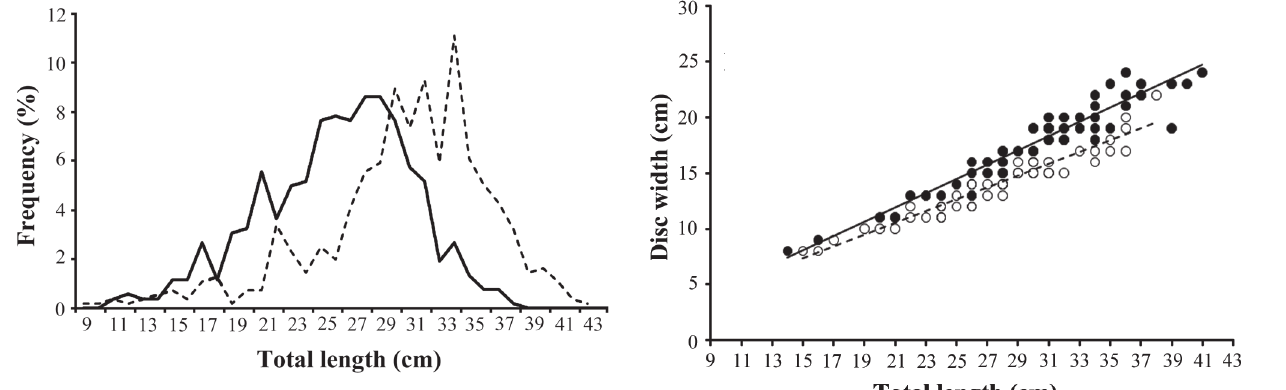
Fig. 4. Size frequency distribution of Discopyge tschudii sampled during 2004-2007. Males (dotted line) n= 564 and females (continuous line) n= 523.